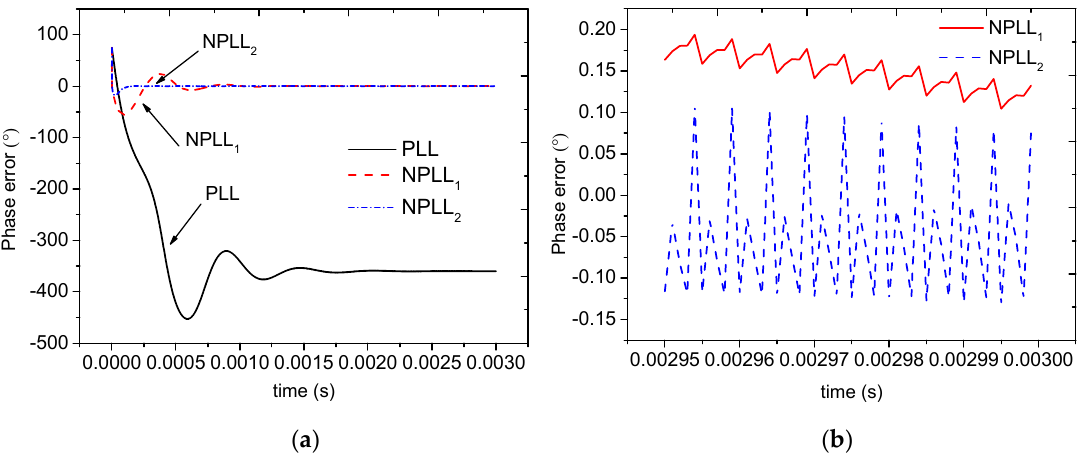
Figure 10. Phase error of PLL under a frequency offset of 4 kHz: ( a ) Phase error of PLL under a frequency offset of 4 kHz; ( b ) Phase error of PLL after 2.95 ms.